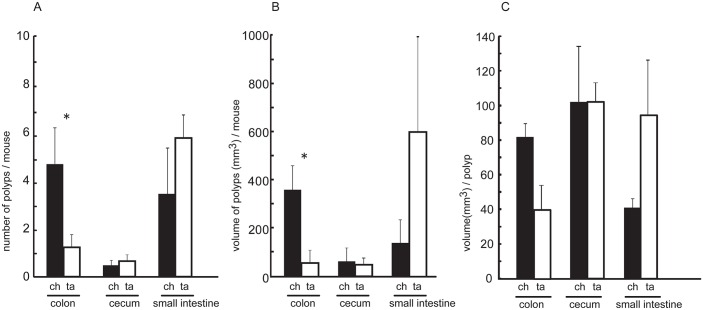
Polyp number and volume in the colon, cecum, and small intestine.A greater number of polyps was detected in the colon than in the ileum of the chlorinated water group (black columns), whereas more polyps occurred in the small intestine in the tap water group (white columns). Polyp volume was correlated with polyp number, and colon polyp volume differed significantly between the two groups. ch; chlorinated water group, ta; tap water group. *P < 0.05 (Student’s t test).